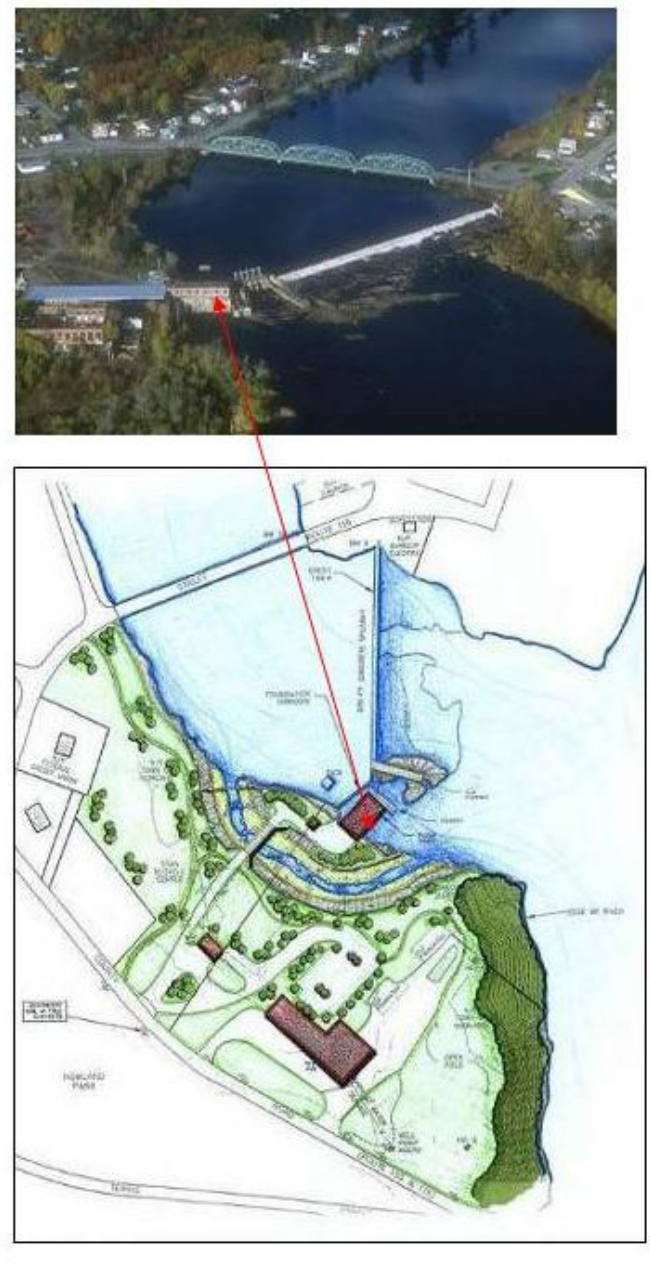
Fig. 3. The design for the fish bypass at Howland Dam, seen in photo. The Red arrows point to the same structure in each image. In the lower image, the narrow blue channel just below the red arrow is the fish bypass (images provided by MMI Engineering courtesy of the Penobscot River Restoration